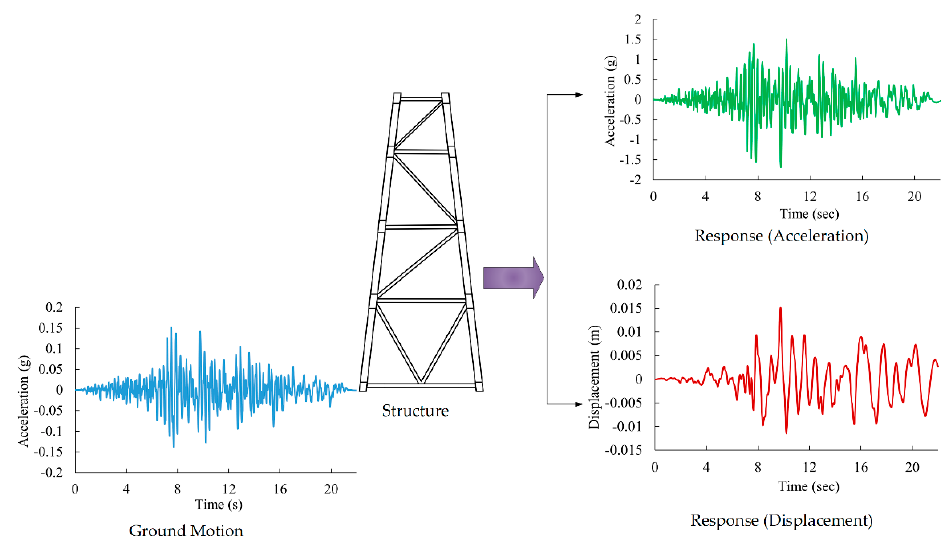
Figure 4. Overview of obtaining responses of model. Table 2. Lists of considered Intensity